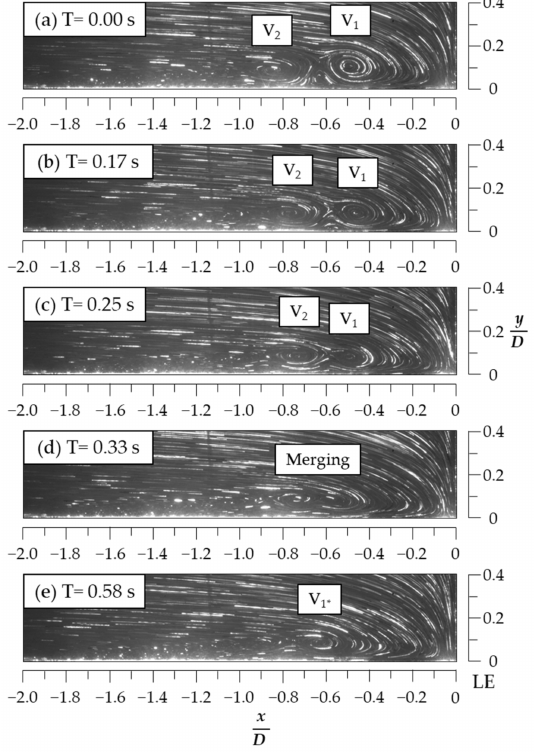
Figure 11. Time-series flow visualization of the HSV’s kinematic mode: “merging” in the z = 0 cm plane when H / D = 1.5. ( a ) The cores of two primary vortices V 1 and V 2 were initially located at ( x / D , y / D ) = ( − 0.49, 0.11) and ( − 0.85, 0.09), respectively; from ( b ) to ( d ), V 2 and V 1 were approach- ing and merging with each other; ( e ) a new primary vortex V 1* formed with its core located at ( x / D , y / D ) = ( − 0.63,